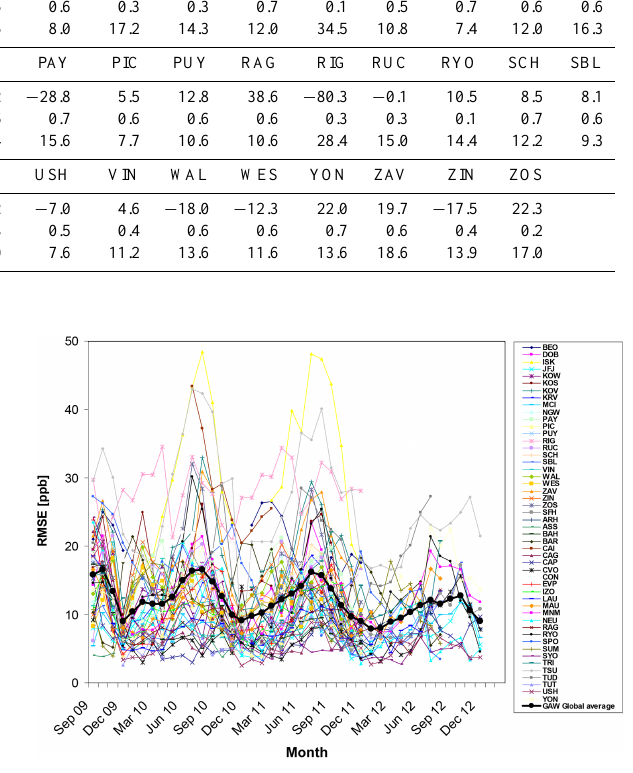
Figure 4. Modified normalised mean bias (MNMB) in % derived from the evaluation of the MACC_osuite with GAW O 3 surface observations during the period September 2009 to December 2012 (black line: global average of 50 GAW stations. Multi-coloured lines: individual station results; see legend to the right).